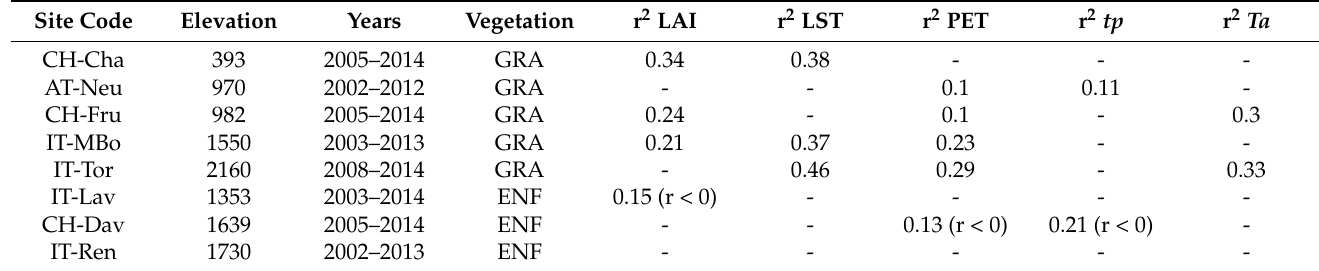
Table 3. r 2 of the linear regression between yearly cumulated ET from eddy flux towers, and yearly aggregated covariates, including (i) MODIS-based LAI, LST, and PET; (ii) MSWEP precipitation ( tp ); and (iii) ground-based air temperature ( Ta ). Ta and LST were averaged during the growing season, whereas the other covariates were cumulated.